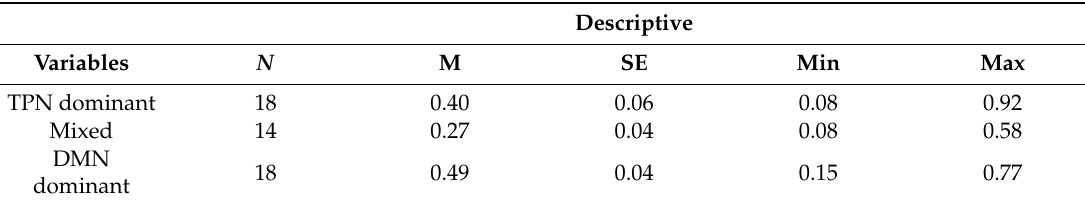
Table 3. Descriptive statistics of total noun-cues recalled (in percentages) as a factor of resting state network